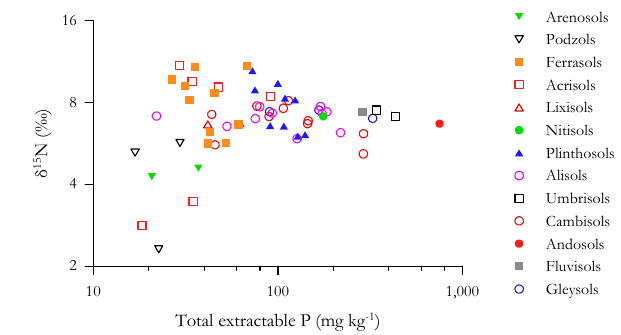
Fig. 11 Fig. 11. Relationship between soil δ 15 N and the total extractable P pool.